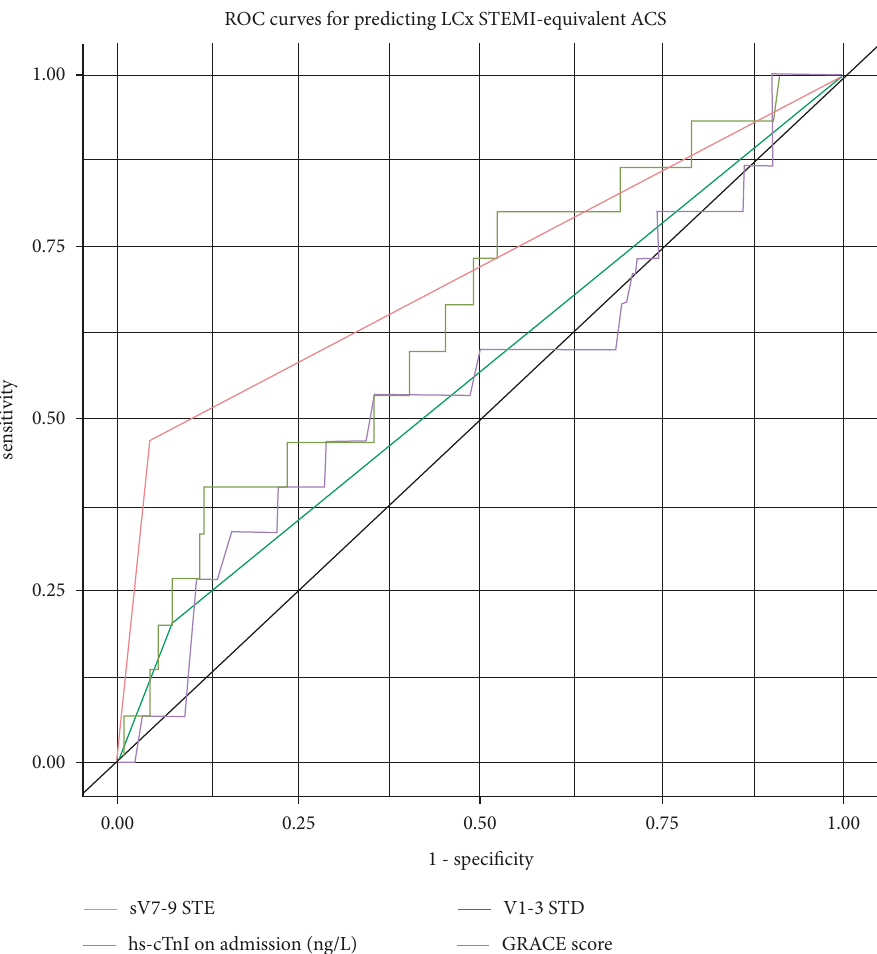
Figure 2: ROC curves for predicting LCx STEMI-equivalent ACS. Comparison of receiver operating characteristics (ROC) curves for typical baseline parameters. The top panel shows the ROC curve for diagnosing left circumflex (LCx) ST-segment elevation myocardial infarction (STEMI)-equivalent acute coronary syndrome (ACS) when defined by thrombolysis in myocardial infarction (TIMI) flow, in which sV7-9 STE showed the best diagnostic performance in terms of area under the curve